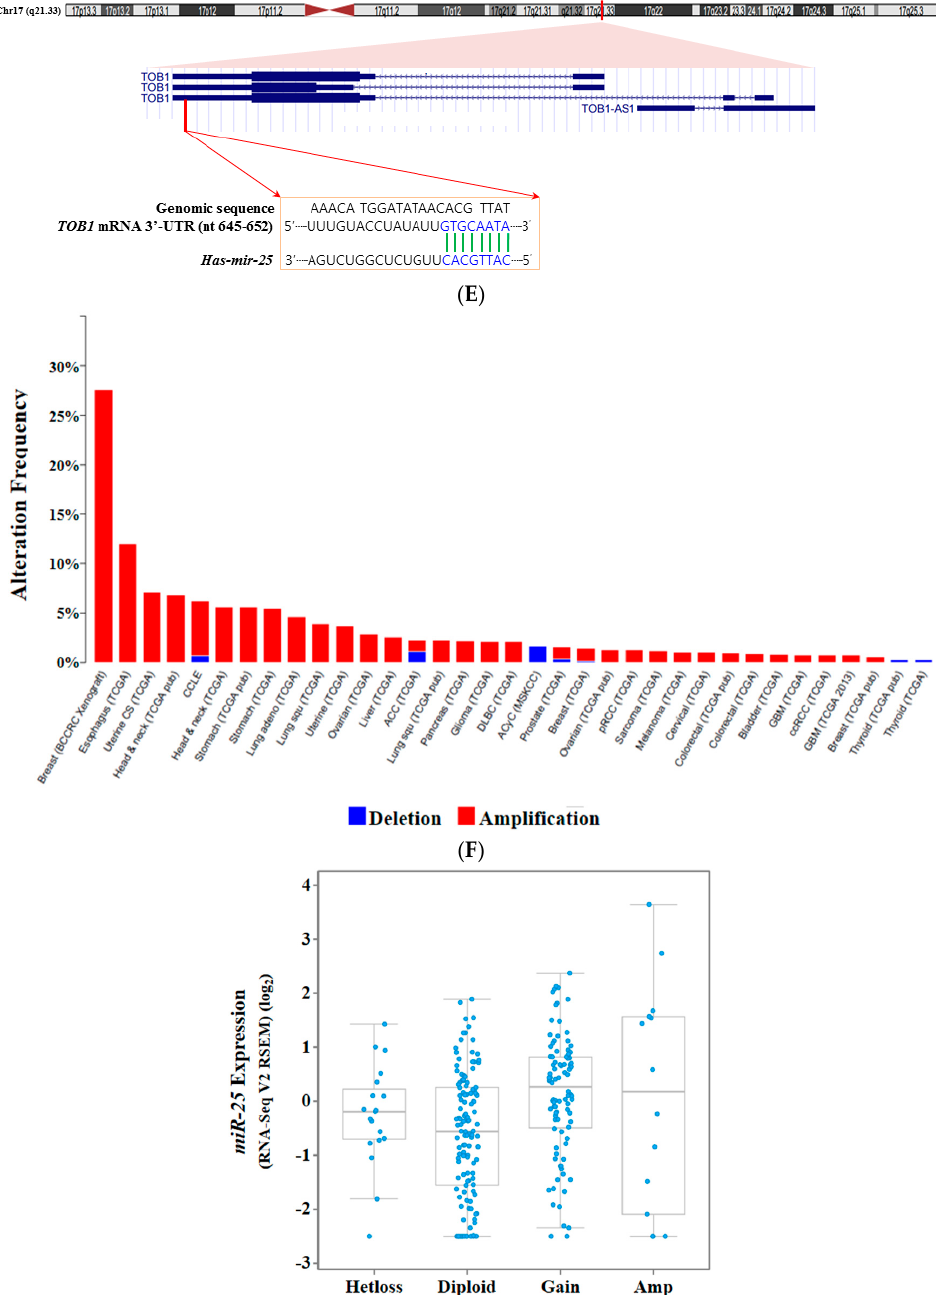
Figure 3. Genomic copy number alteration and expression of AURKA , SAMD4 , and miR-25 in TCGA human clinical cancer samples across a variety of cancer types. ( A ) Genomic copy number amplification of AURKA in human clinical cancer samples; ( B ) Up-regulation of AURKA expression in human stomach cancer samples, showing its gain and amplification; ( C ) Genomic copy number deletion of SAMD4 in human clinical cancer samples; ( D ) Down-regulation of SAMD4 expression in human stomach cancer samples, showing its deletion; ( E ) Binding of miR-25 to TOB1 mRNA 3 ′ -UTR; ( F ) Genomic copy number amplification of miR-25 in human clinical cancer samples; and ( G ) Up-regulation of miR-25 expression in human stomach cancer samples, showing its gain and amplification.